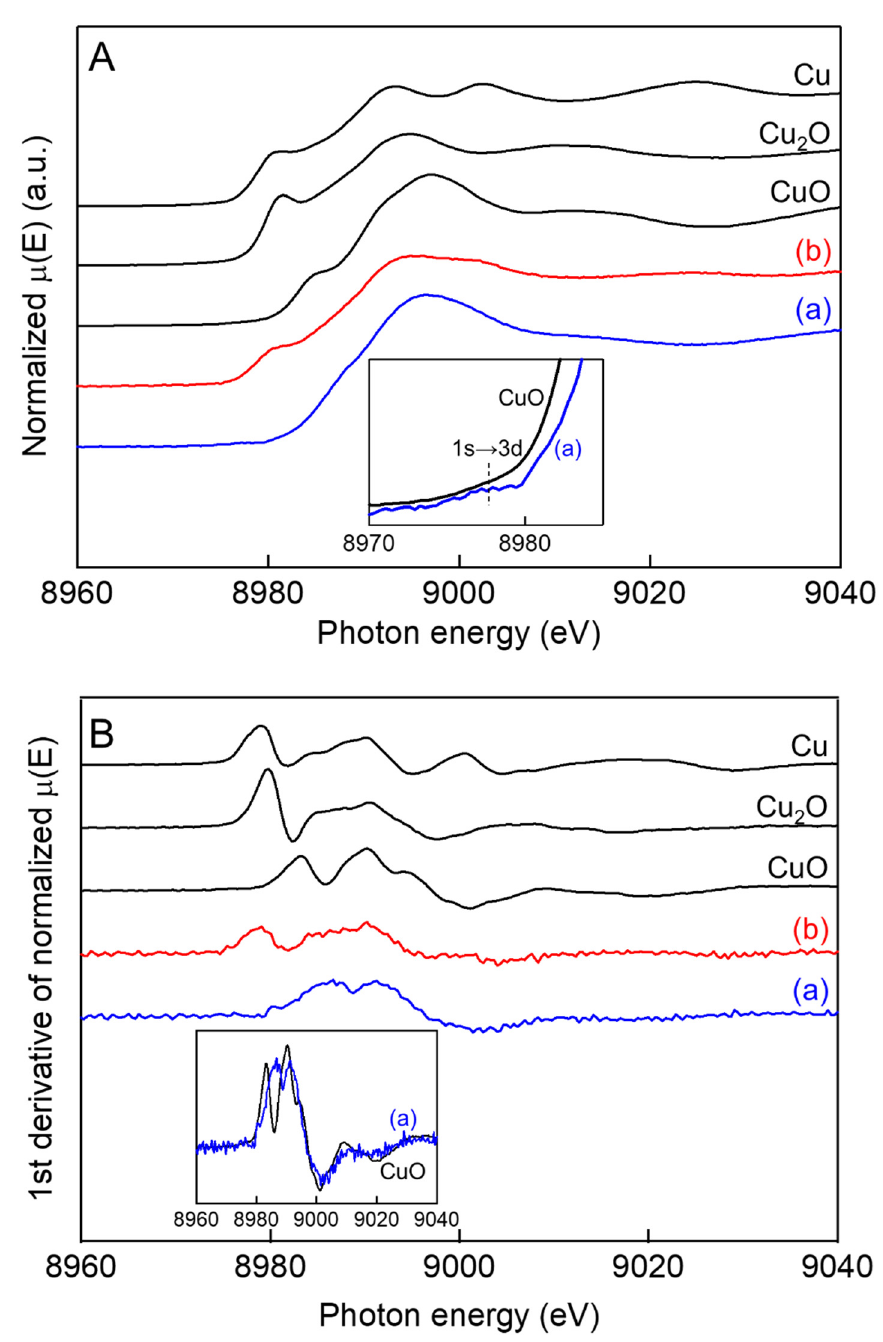
Figure 5. Cu K-edge spectra ( A ) and first derivative of Cu K-edge XANES spectra ( B ) of reference compounds. (a) Cu-TiO 2 , (b) Cu-TiO 2 -H. The inset figure shows overlay of the spectra of CuO and (a) Cu-TiO 2 .